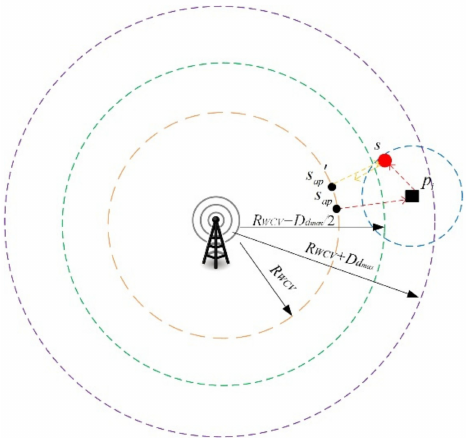
Figure A2. There exists an available flight path from a releasing stop to the target node which is covered by a pad located in a ring area surrounding the WCV region (Case 2).